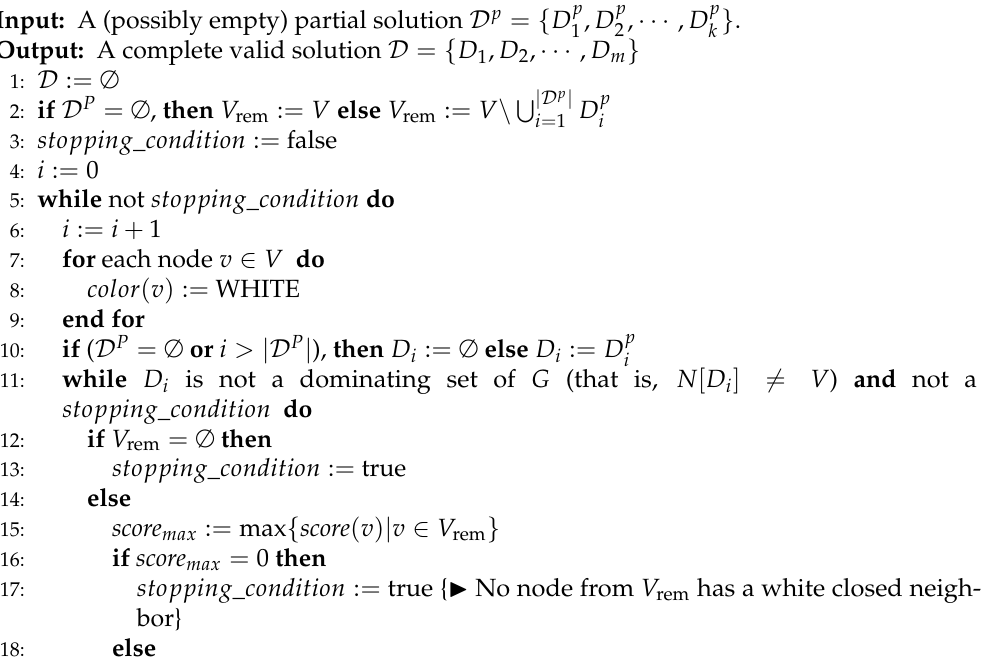
Algorithm 2 Procedure GreedyMWDDS ( D P )